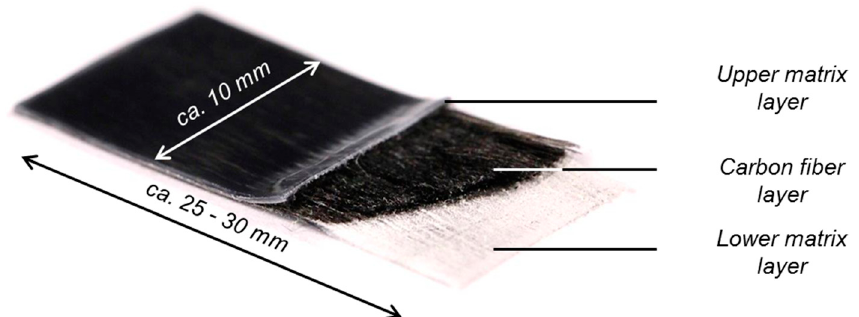
Figure 2. Ultrasonically fabricated CFRP made of carbon fibers between two layers of polypropylene (PP). The thickness of the sample was approximately 470 µm. To demonstrate that the fibers were embedded fully, the upper matrix layer was cut off and removed partly.